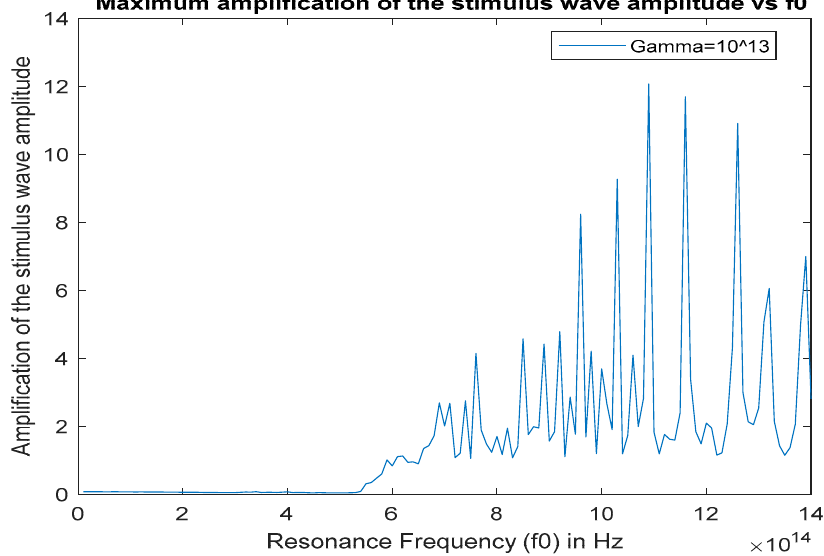
Figure 10. Maximum stimulus wave amplitude (gain factor) inside the cavity at x = 5.73 μ m for 0 < t < 30 ps, 𝛾 = 1 × 10 (cid:2869)(cid:2870) Hz , versus 𝑓 (cid:2868) . The amplification for 𝛾 = 10 (cid:2869)(cid:2871) Hz is almost insignificant as shown in Figure 11. At this damping